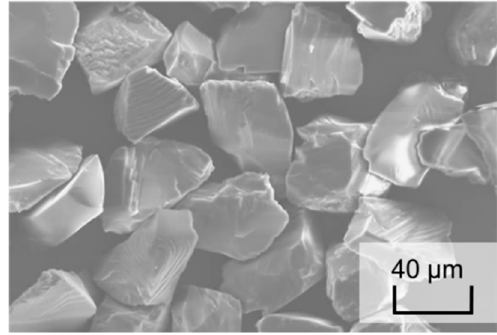
Figure 2. SEM image of alumina particles used as erodents in this study. The average diameter of the particles is about 40 mm.